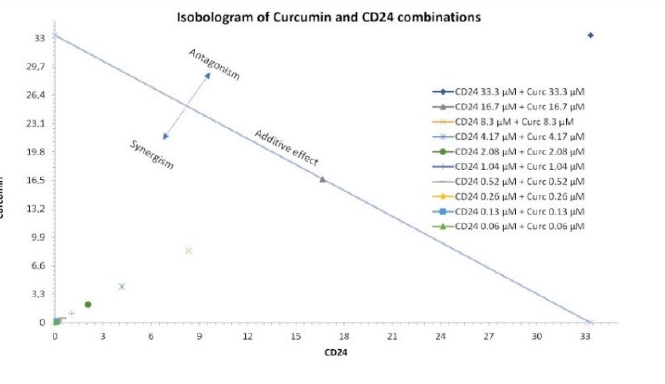
Figure 6. Classic isobologram for CD24 and curcumin with used doses on the x ‐ and y ‐ axis. Finally, the cytotoxicity of CD24, curcumin alone, and CD24 in combination with curcumin was assessed towards HEK293 cell lines, by using the range of concentrations 70–0.5 μ M. In both cases, no cytotoxic effects were observed up to 70 μ M. All in all, the nutraceutical showed the highest selectivity index (SI), while the syn ‐ thetic inhibitor alone showed the lowest SI. The combination of CD24 + curcumin showed a SI slightly lower than that of curcumin, thus signifying a productive use of the inhibitors in combination, considering their strong synergistic action against rhodesain. 3. Materials and Methods 3.1. Rhodesain Inhibition Assays CD24 was synthesized as previously reported by our group [29]. Curcumin was pur ‐ chased from Sigma Aldrich. ‐ Merck Life Science (Milan, Italy) Rhodesain was recombi ‐ nantly expressed by our group, as previously described by Caffrey et al. [39]. Preliminary screening with rhodesain was performed with inhibitor concentrations of 100 μ M, 1 μ M, and 0.1 μ M, to identify the range of activity of CD24 and curcumin. An equivalent amount of DMSO was used as negative control. Product release from substrate hydrolysis (Cbz ‐ Phe ‐ Arg ‐ AMC, 10 μ M) was determined continuously over a period of 10 min at room temperature. The assay buffer contained 50 mM sodium acetate, pH = 5.5, 5 mM EDTA, 200 mM NaCl, and 0.005% Brij 35, to avoid aggregation and false ‐ positive results. Enzyme buffer contained 5 mM DTT rather than Brij 35. Inhibitor solutions were prepared from stocks in DMSO. As a first step, CD24 and curcumin were separately tested two times in duplicate in 96 well plates in a total volume of 200 μ L. In more detail, we used 0.05 μ M, 0.1 μ M, 0.25 μ M, 0.5 μ M, 1 μ M, 10 μ M, and 20 μ M for CD24 , while 5 μ M, 10 μ M, 20 μ M, 40 μ M, 60 μ M, 80 μ M, and 100 μ M were used for curcumin. Fluorescence of the product AMC of the substrate hydrolyses was measured using an Infinite 200 PRO microplate reader (Tecan, Männedorf, Switzerland) at room temper ‐ ature, with a 380 nm excitation filter and a 460 nm emission filter. Results are expressed as IC 50 values ± SD and were calculated by fitting the progress curves to the 4 parameter IC 50 equation using GRAFIT software 5.0 (GraFit, version 5.0.1.3; Erithacus Software Ltd.: London, UK, 2006): y (cid:3404) y (cid:2923)(cid:2911)(cid:2934) (cid:3398) y (cid:2923)(cid:2919)(cid:2924) I (cid:3397) (cid:3436) (cid:4670) I (cid:4671) IC (cid:2873)(cid:2868) (cid:3440) (cid:2929) (cid:3397) y (cid:2923)(cid:2919)(cid:2924) with y [ Δ F/min] as the substrate hydrolysis rate, y max as the maximum value of the dose − response curve, measured at an inhibitor concentration of [I] = 0 μ M, y min as the minimum value, obtained at high inhibitor concentrations, and s as the Hill coefficient. As a second step, CD24 and curcumin were tested in combination using 5 data points: 0.25 × IC 50F1+F2 , 0.50 × IC 50F1+F2 , IC 50F1+F2, 2 × IC 50F1+F2 , 4 × IC 50F+F2 , where F1 = CD24 and F2 = curcumin.